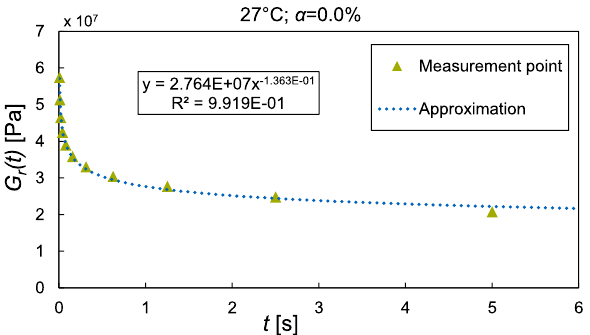
Figure 5: Analysis example – Torsion Bar Test: relaxation modulus G r vs. time t .